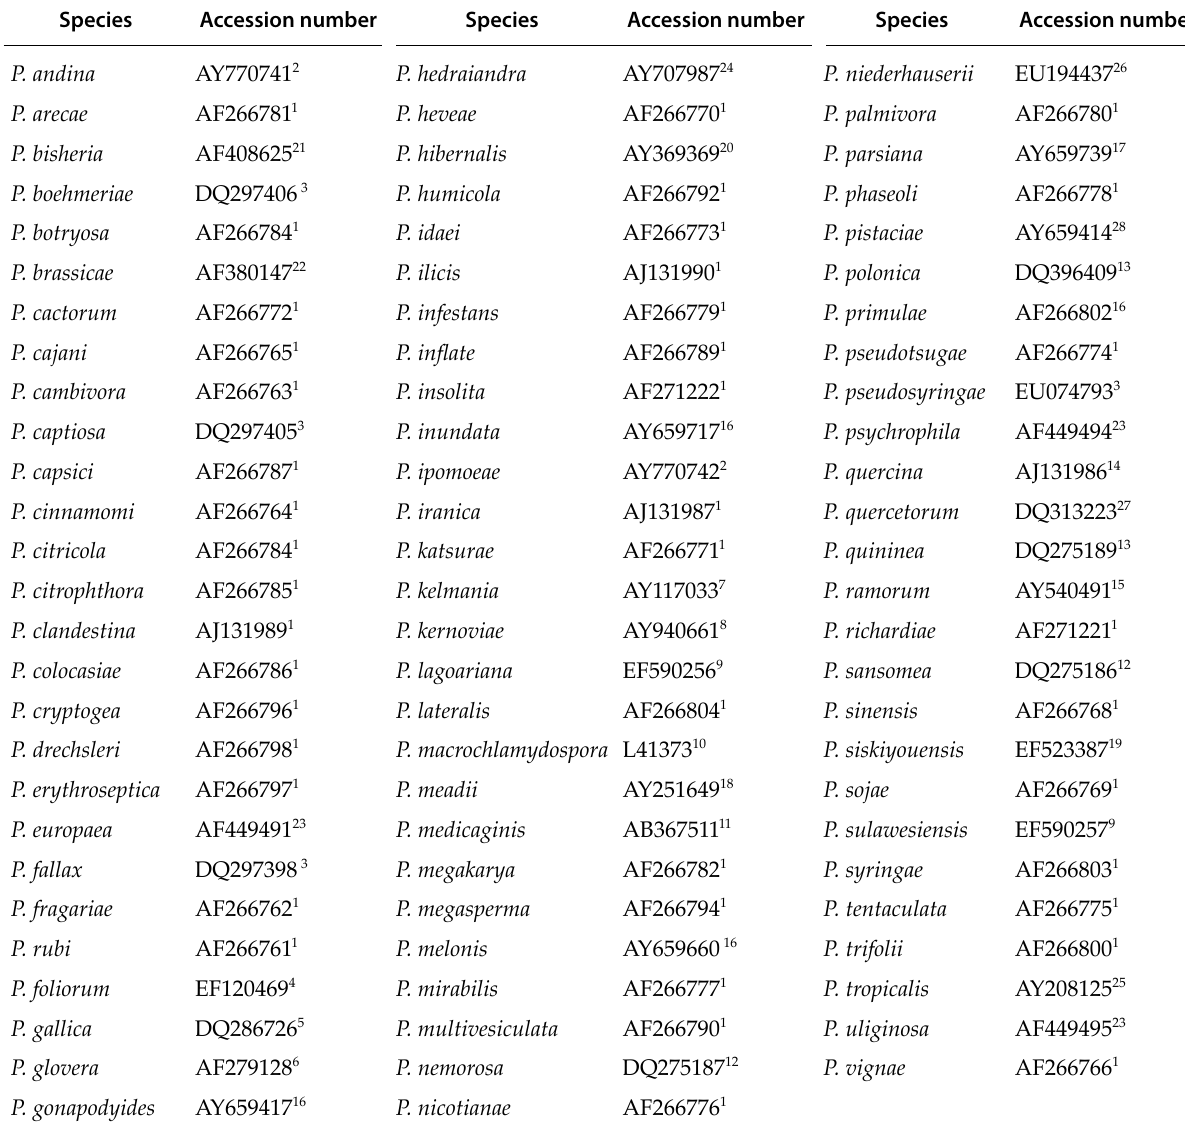
Table 5. GenBank accession numbers of internal transcribed spacer sequences of rDNA (ITS) of Phytophthora species used for phylogenetic